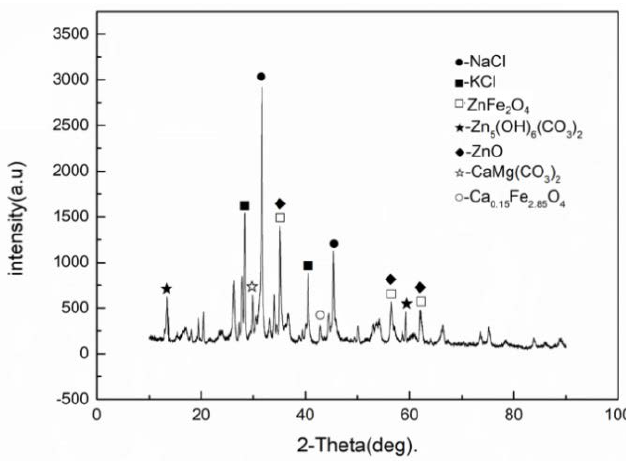
Figure 8. XRD diffraction pattern of leach residue (Na 2 CO 3 is 1.25 times the basic addition amount, L/S 6:1).